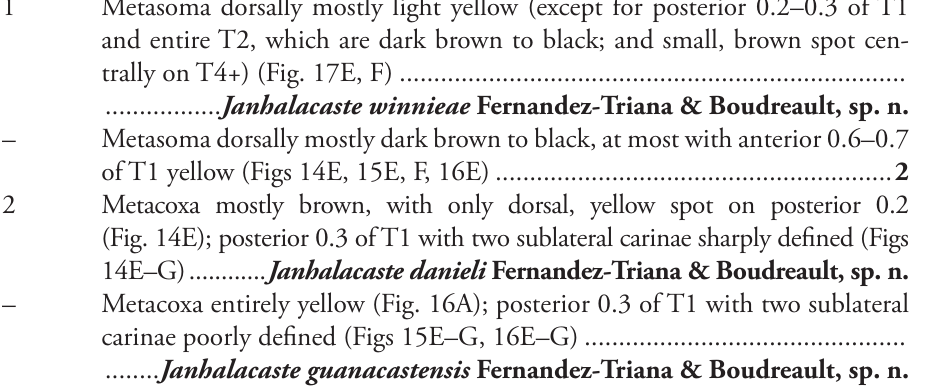
Metacoxa mostly brown, with only dorsal, yellow spot on posterior 0.2 (Fig. 14E); posterior 0.3 of T1 with two sublateral carinae sharply defined (Figs 14E–G) ............ Janhalacaste danieli Fernandez-Triana & Boudreault, sp. n. Metacoxa entirely yellow (Fig. 16A); posterior 0.3 of T1 with two sublateral carinae poorly defined (Figs 15E–G, 16E–G) ...............................................